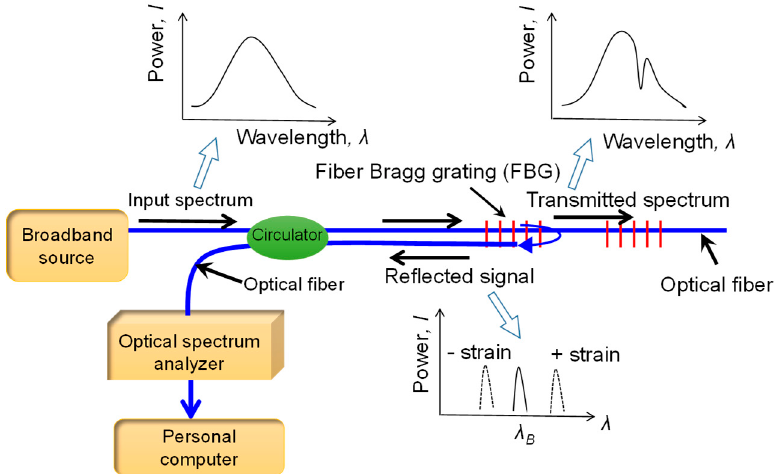
Figure 1. Working principle of the fiber Bragg grating (FBG) sensor.